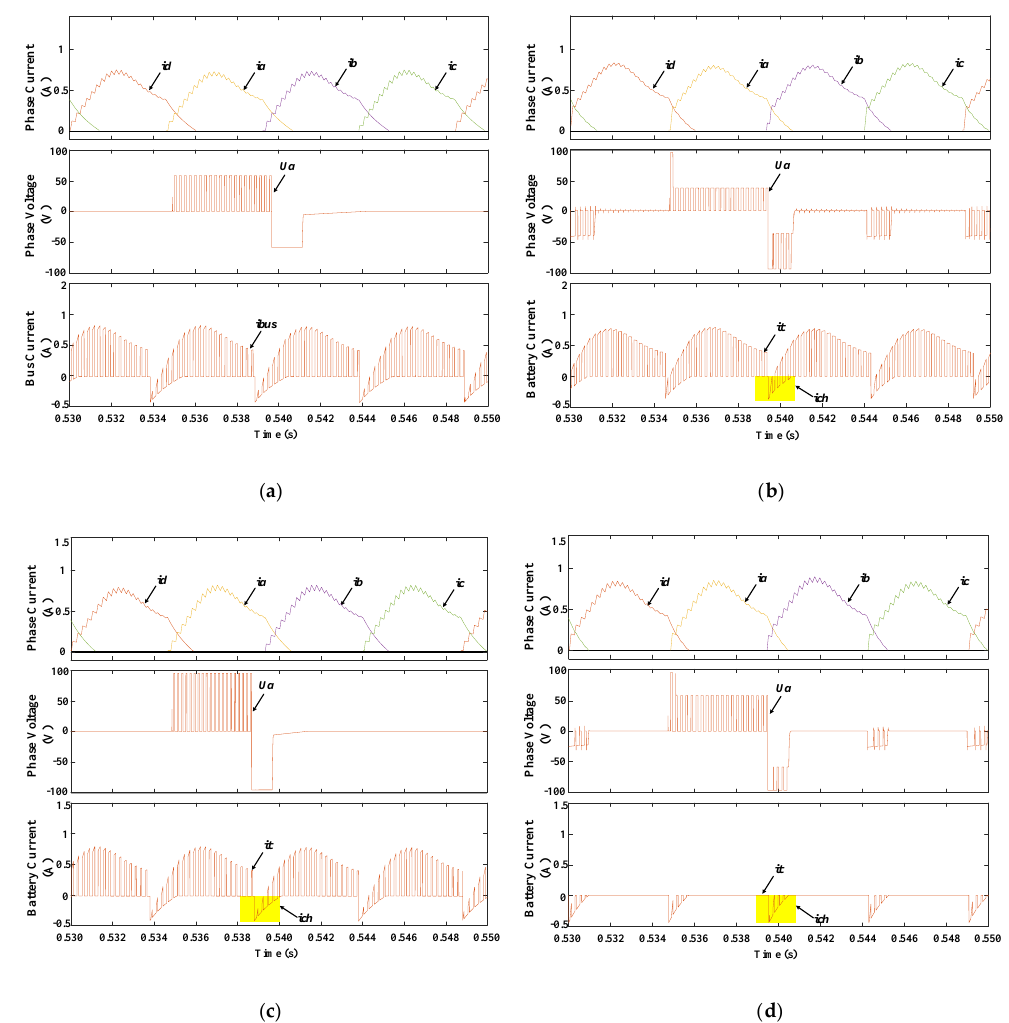
Figure 8. The simulation waveforms of the proposed motor drive operating at 600 rpm. ( a ) Driving by AHT. ( b ) Powering by the battery pack. ( c ) Powering by the PV panels and battery bank together. ( d ) Powering by the PV panels.